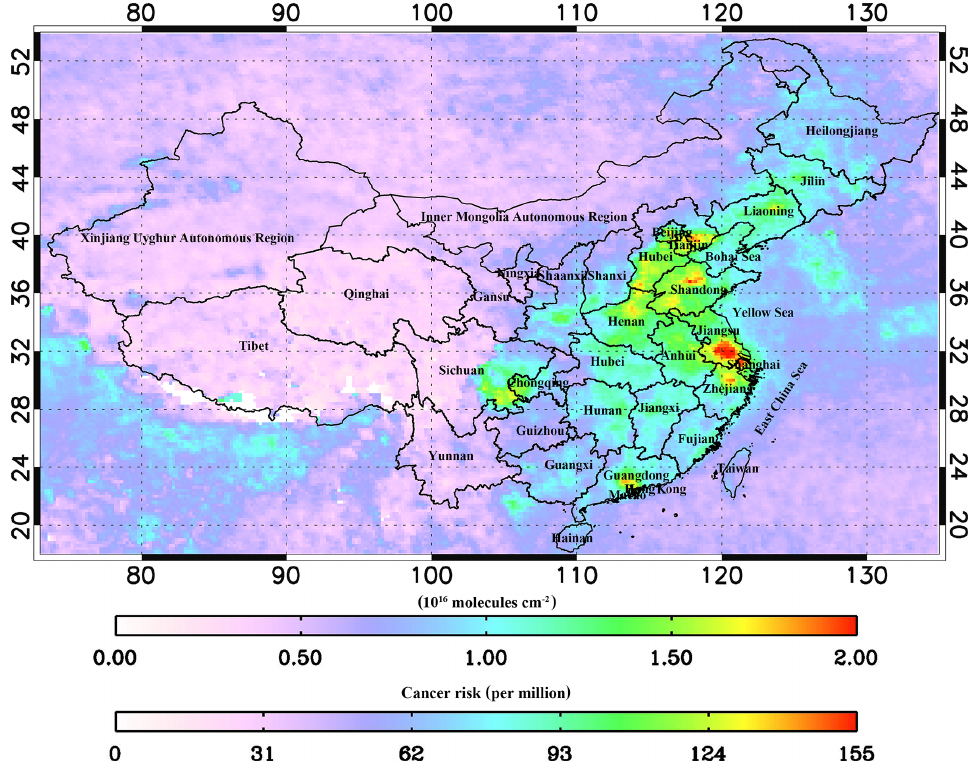
Figure 3. The spatial distribution of monthly averaged tropospheric HCHO VCDs observed by OMPS and the cancer risk in August